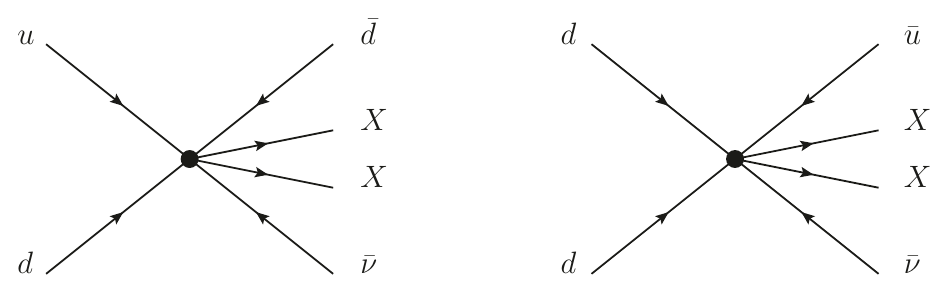
Figure 2 . Feynman diagrams for pp j(cid:23)XX production at the LHC from operator (2.7). ! which contributes to jet(s) + MET (cid:12)nal state as shown in (cid:12)gure 2. We have included